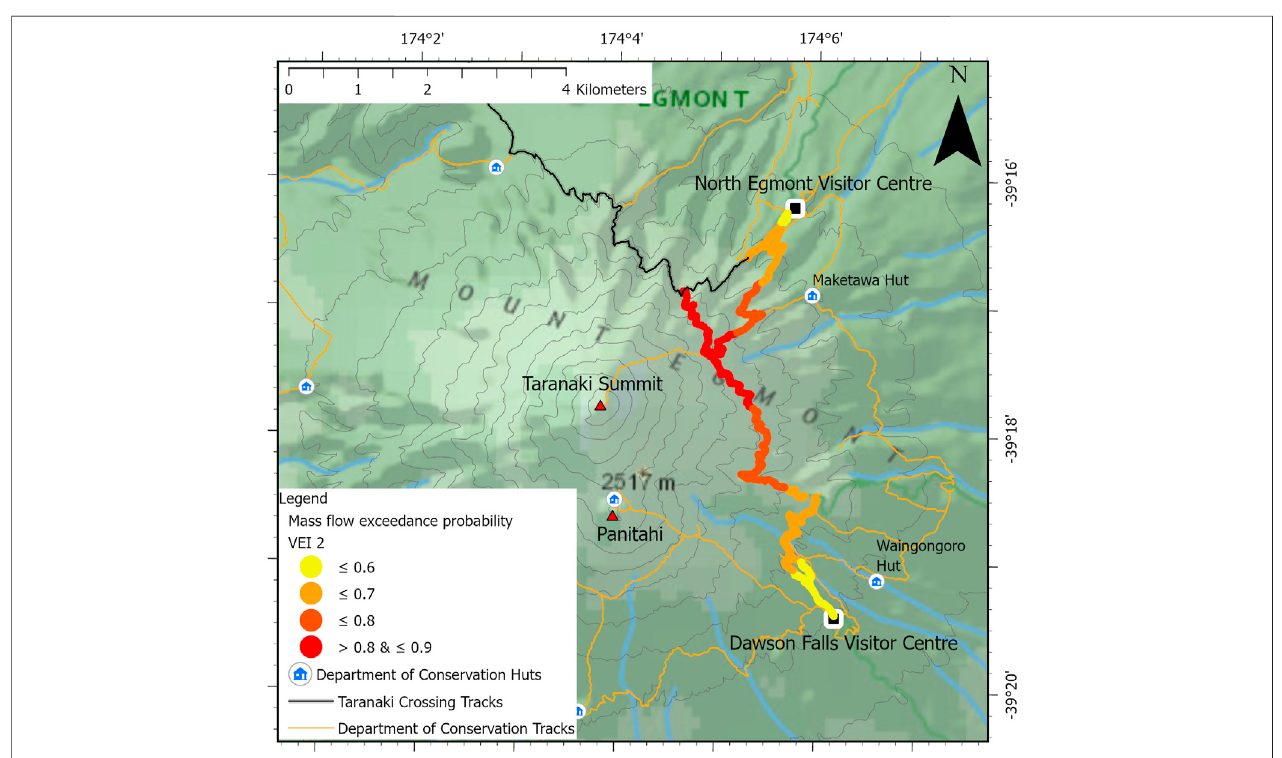
FIGURE 7 | Exceedance probability for volcanic mass fl ows reaching or travelling further than Taranaki crossing track following a VEI ≤ 2 eruption.